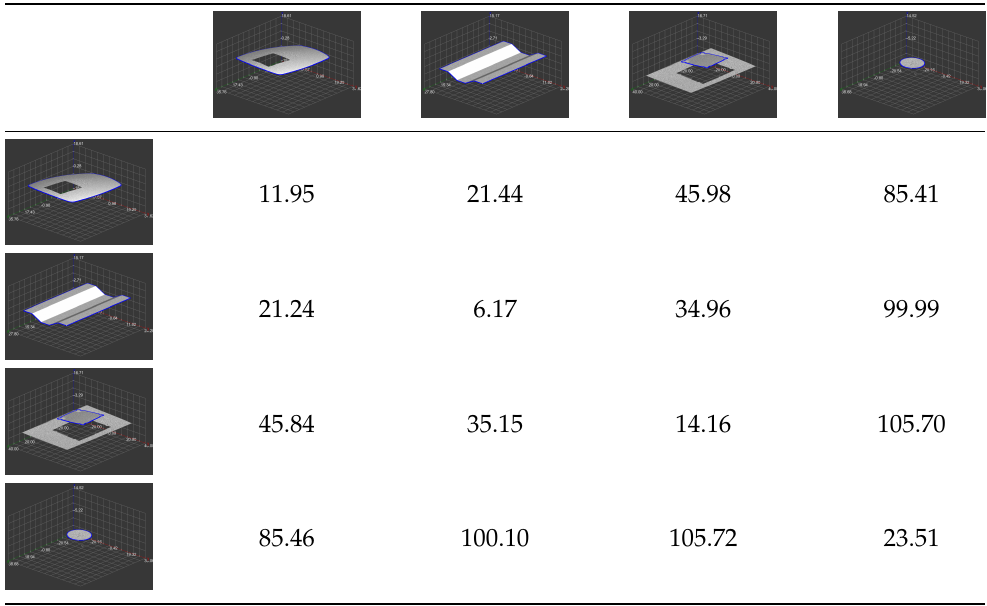
Table 1. The average shape distances for selected types of samples.